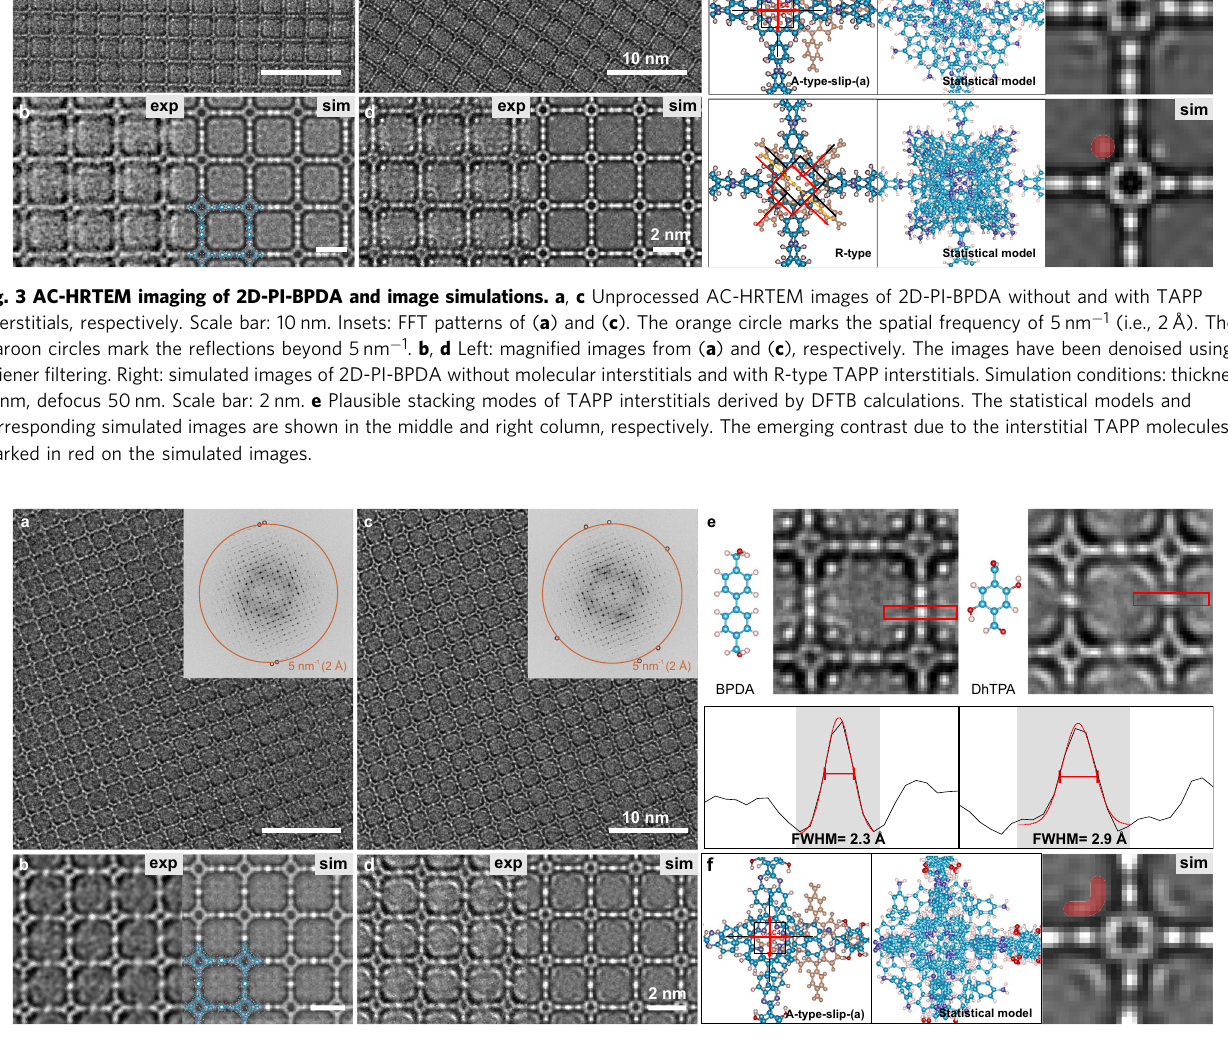
Fig. 4 AC-HRTEM imaging, image simulation of 2D-PI-DhTPA, and comparison of the linker width with 2D-PI-BPDA. a , c Unprocessed AC-HRTEM images of 2D-PI-DhTPA without and with TAPP interstitials, respectively. Scale bar: 10 nm. Insets: FFT patterns of ( a ) and ( c ). The orange circle marks the spatial frequency of 5 nm − 1 (i.e., 2 Å). The maroon circles mark the re fl ections beyond 5 nm − 1 . b , d Left: magni fi ed images from ( a ) and ( c ) respectively. The images have been denoised using Wiener fi ltering. Right: simulated images of 2D-PI-DhTPA without molecular interstitials and with A-type-slip-( a ) TAPP interstitials. Simulation conditions: thickness 20 nm, defocus 40 nm. Scale bar: 2 nm. e Upper row: real-space-averaged images of 2D-PI-BPDA and 2D-PI-DhTPA, respectively. Lower row: integrated line pro fi les obtained from the boxed regions in the images. The FWHMs of the linker width are 2.3 Å and 2.9 Å, respectively. f DFTB models of A-type-slip-( a ) TAPP interstitials in 2D-PI-DhTPA. The emerging contrast due to interstitials is marked in red on the simulated the 4-Å-sized pore on the porphyrin rings 37 , which is not possible nodes and BPDA/DhTPA linker molecules unambiguously. Note that the contrast enhancement under 120 kV enables image at 300 kV due to the necessity of higher defocus values for image acquisition with low defocus values (i.e., 40 – 50 nm), thus sig- visibility (Supplementary Fig. S9). ni fi cantly reducing contrast delocalization 36 . In other words, the image signal is sharply localized on the molecular framework image and simulation is well maintained in most of the sample without substantial blurring. Together with the sub-2-Å areas, we occasionally observe abnormal contrast in the vicinity of resolution, low delocalization allows the visualization of even the porphyrin cores in both 2D polymer materials (Figs. 3c and 4c).